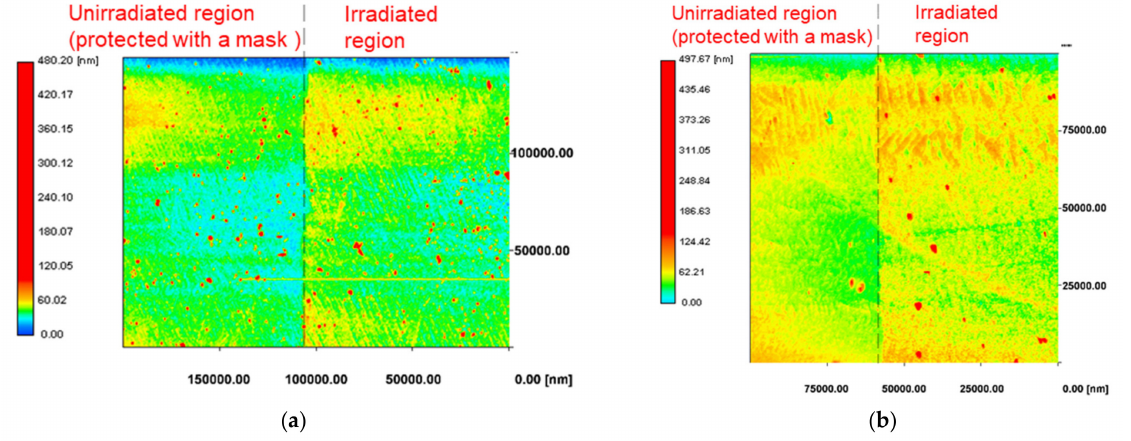
Figure 3. Example AFM images including a boundary between unirradiated (protected) and irradi- ated (exposed) regions of pure Ti bulk surfaces irradiated with 5.1-MeV Si 2+ ions at 573 K, at fluences